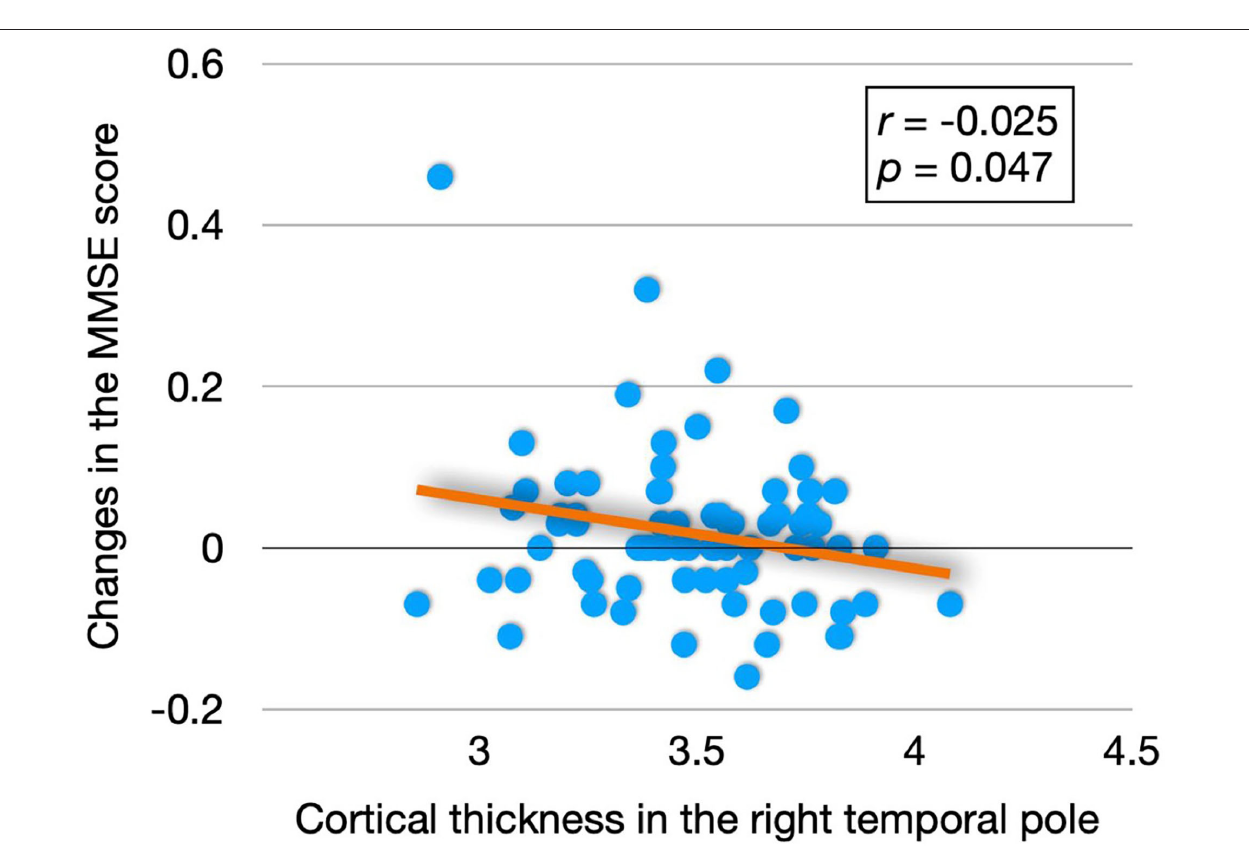
FIGURE 2 | Relationship between MMSE score and right temporal pole cortical